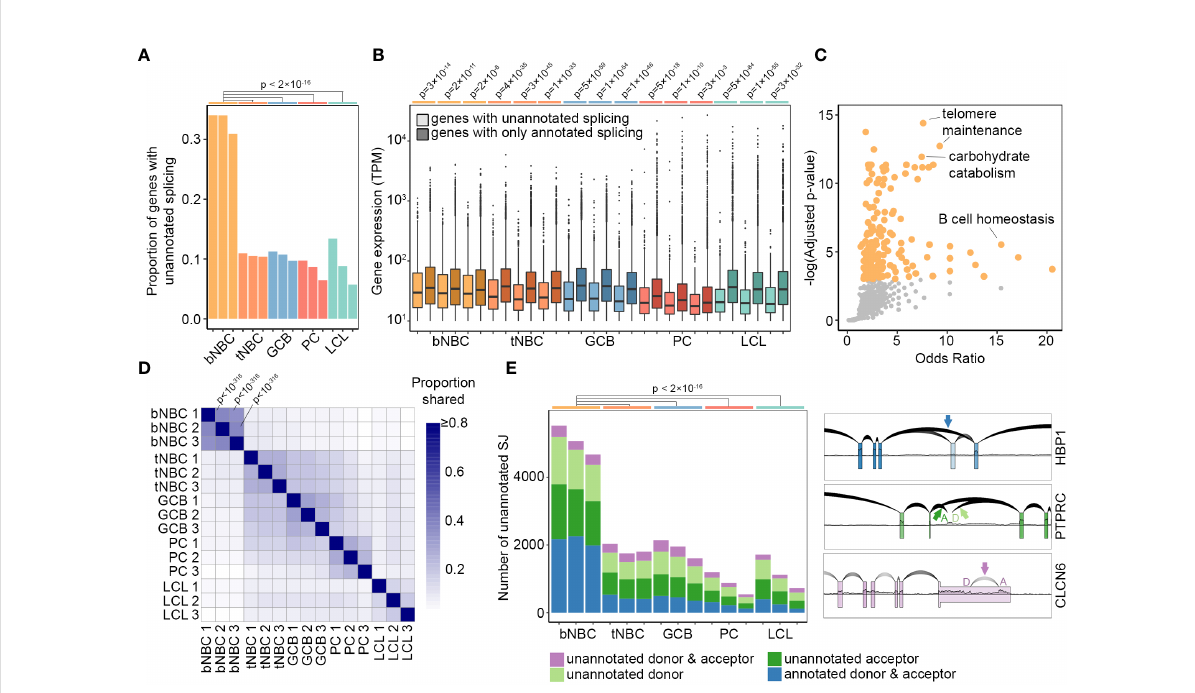
FIGURE 1 Pervasive unannotated splicing in blood naïve B cells. (A) Proportion of robustly expressed genes (TPM > 10) with high-con fi dence unannotated splicing in B cell subsets and LCL samples. P-values calculated using pairwise comparison of proportions test with Bonferroni correction. (B) Gene expression level in TPM (minimum = 10) by splice junction annotation status and sample. Lighter colors represent genes containing unannotated splice junctions, darker colors represent genes with annotated splicing only. P-values calculated by Wilcoxon rank sum test